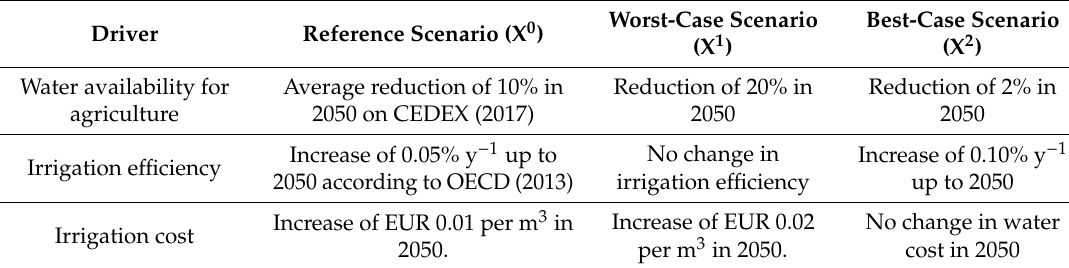
Table 1. Scenario